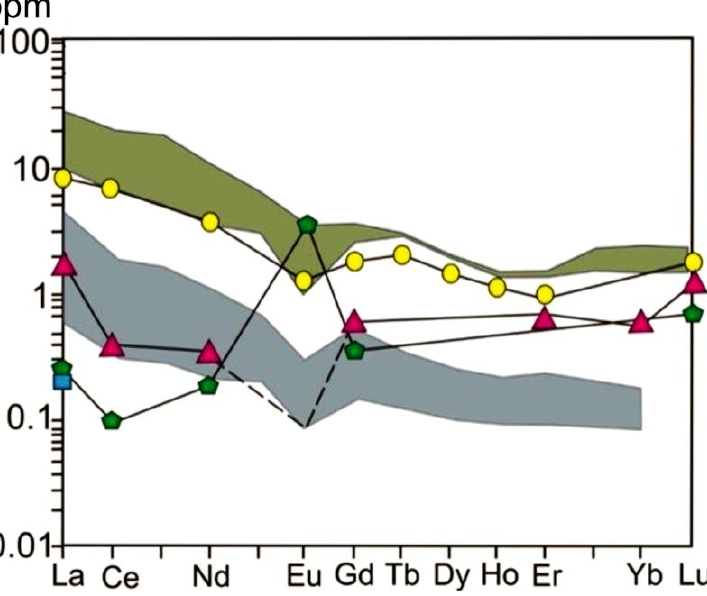
Figure 7. Chondrite-normalized REE distribution in K-feldspar (average data from Tables 2 and 4, same symbols as in Figure 6) and bulk pegmatite (green field is for feldspar pegmatites ( n = 2), grey field is for albite-spodumene pegmatites ( n = 5); data after Morozova